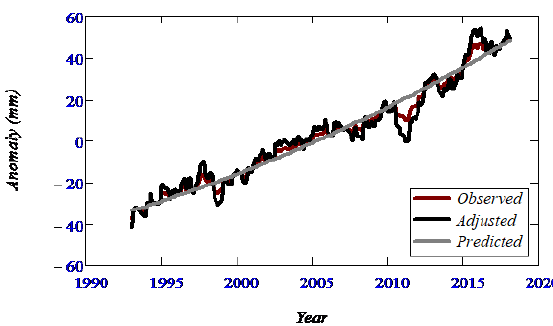
Fig. 5. The visual synopsis of the GLS solution inclusive of the trend and the contingent acceleration during 1993 -